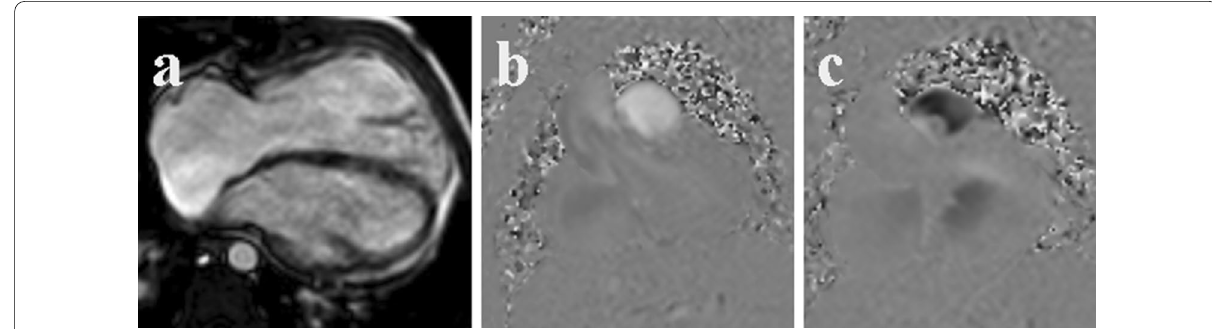
Fig. 3 Female child 9 years old came for follow after 7 years post Fallot repair, Holter showed no evidence of arrhythmia, CMR showed moderate